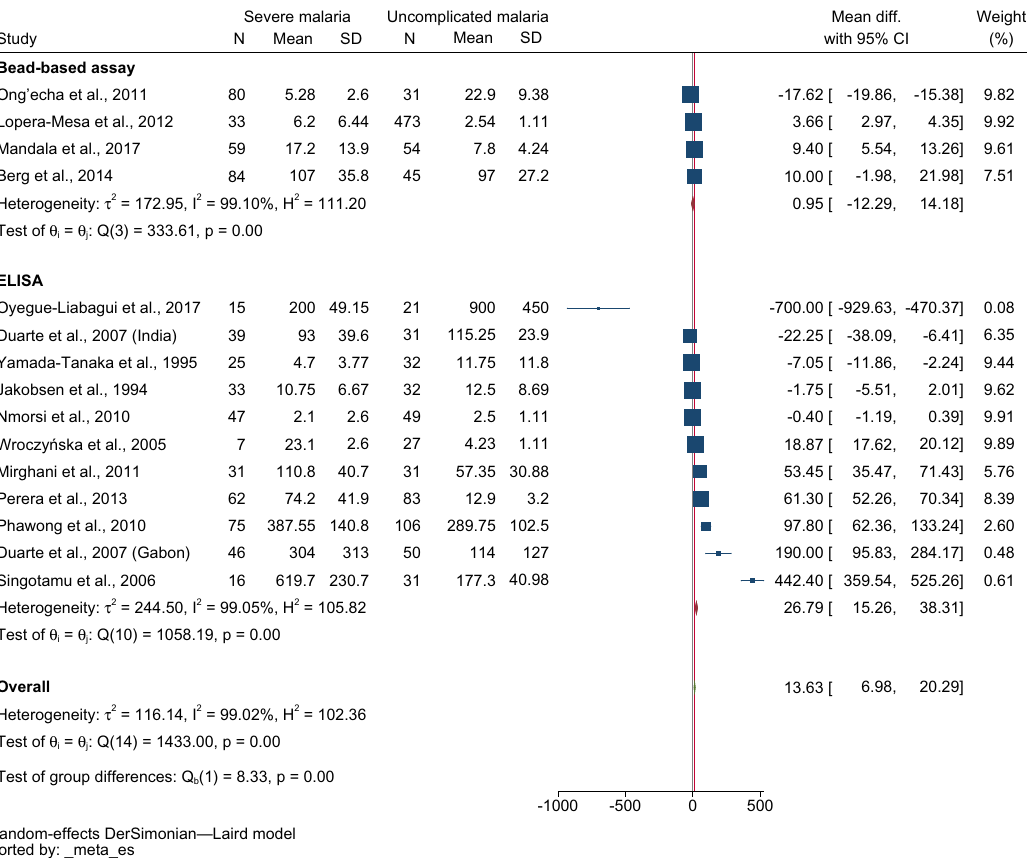
Figure 6. Forest plot demonstrating the pooled MD of INF-γ levels between patients with severe and uncomplicated malaria stratified by methods for INF-γ measurement. CI confidence interval; SD, standard